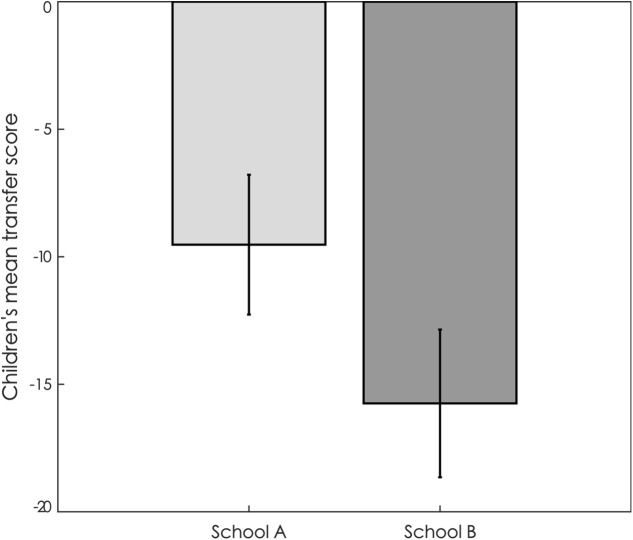
Mean transfer score in children from School A and School B. Error bars represent standard errors to the mean.